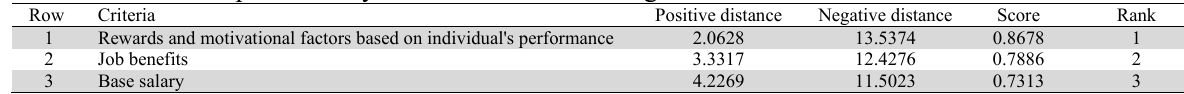
The results of compensation system sub-criteria